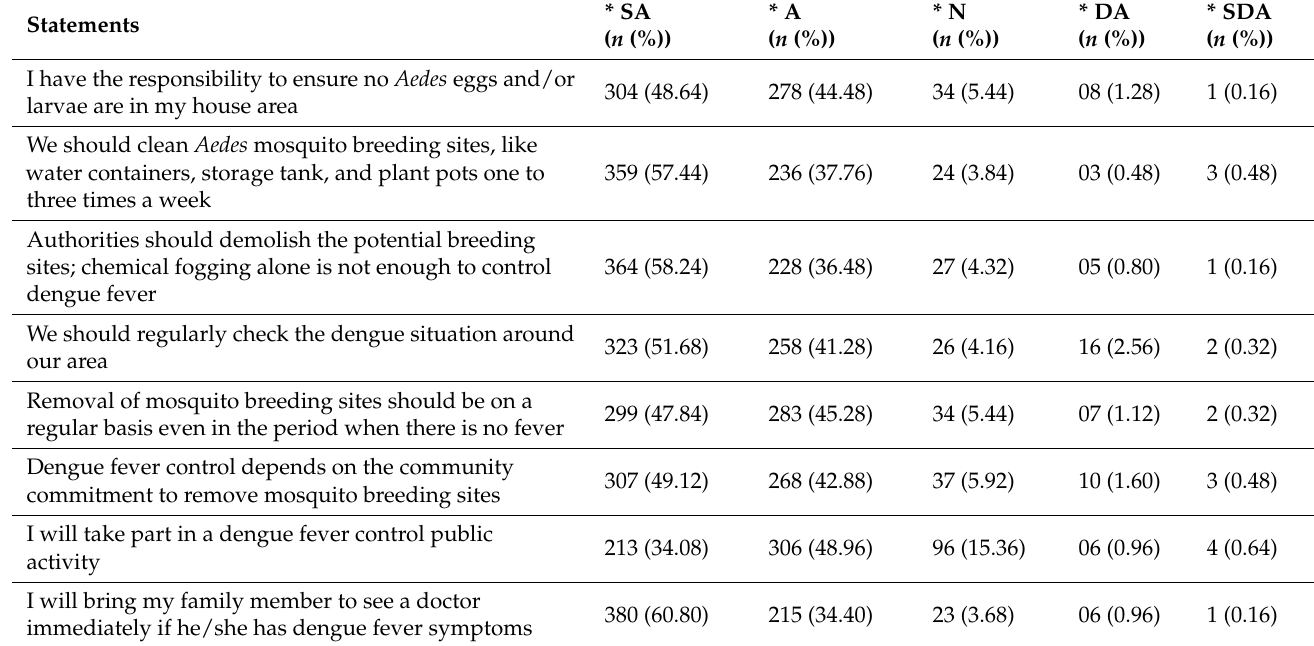
Table 3. Attitude towards dengue fever among university students of Dhaka city, Bangladesh.